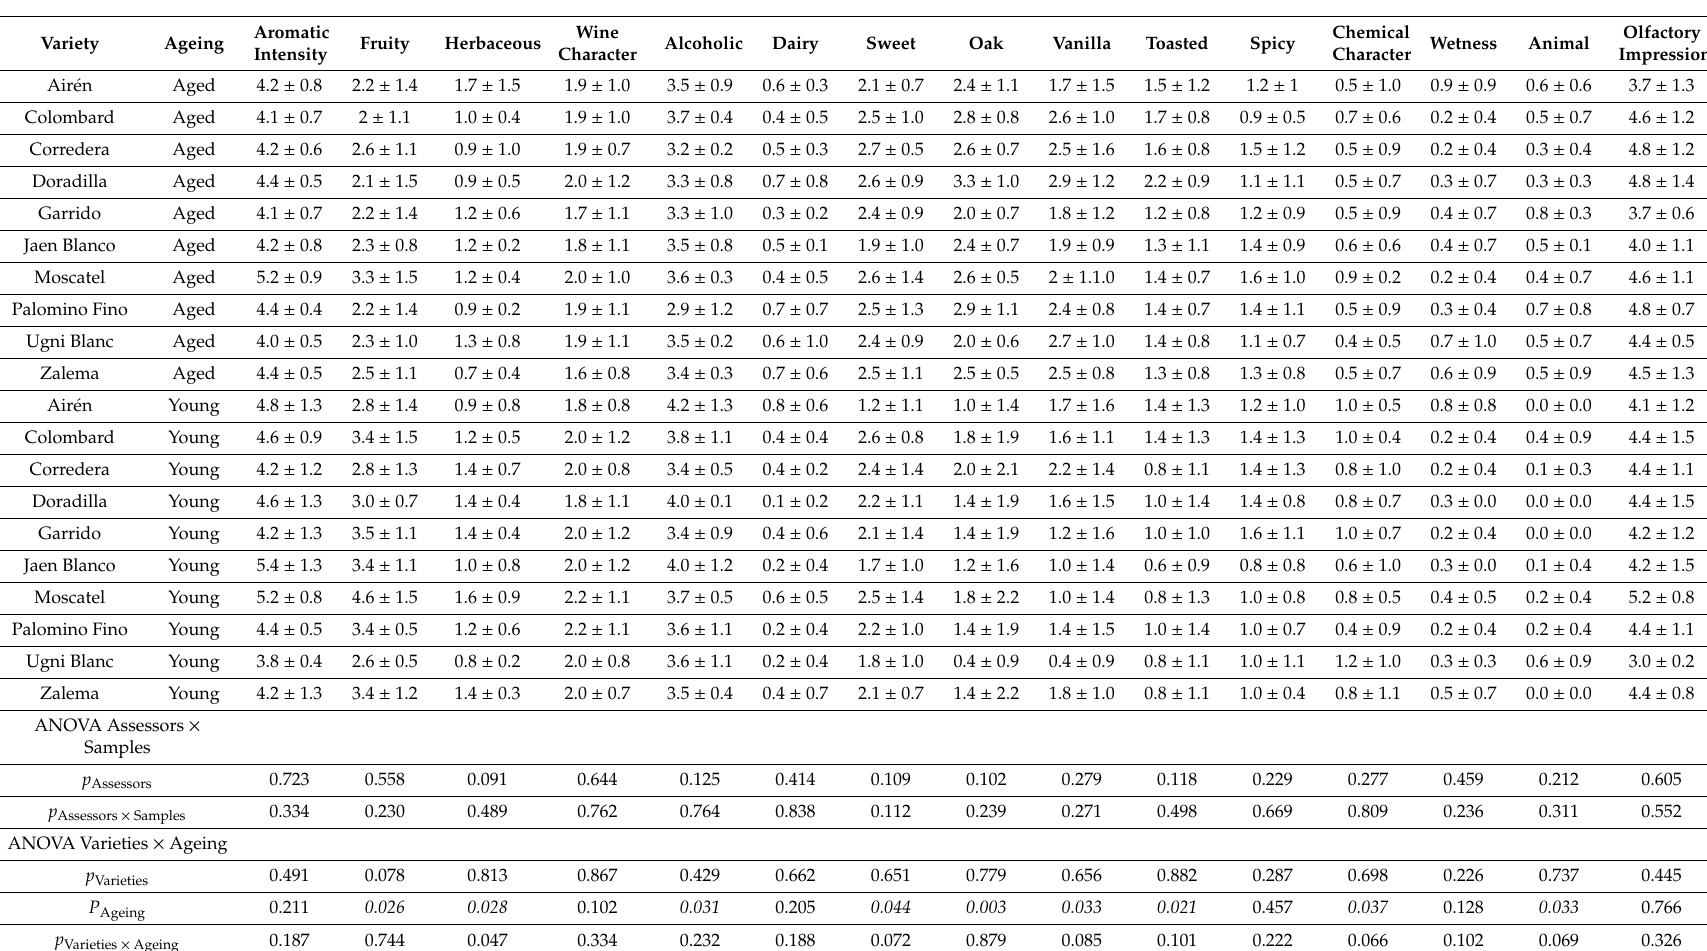
Table 6. Average scores ( ± standard deviation) given by the tasting panel for the samples regarding each of the olfactory descriptors used for their sensory assessment. Variety